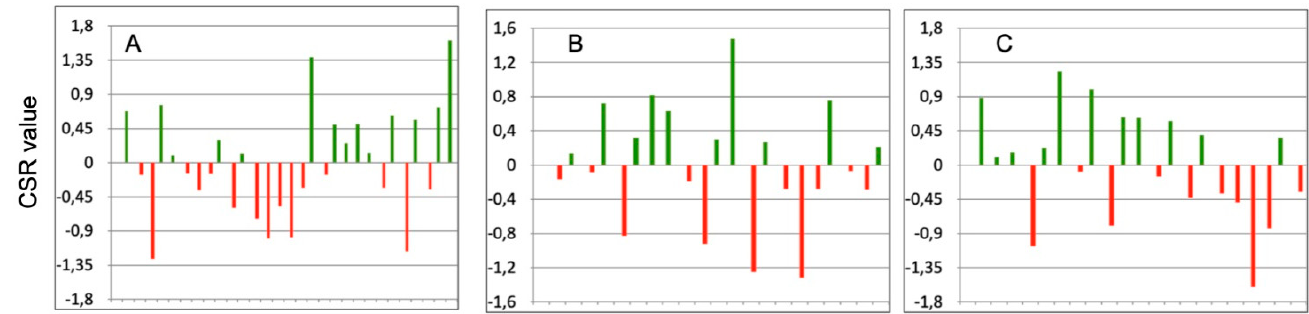
Figure 1. The values of CSR A ( A ), CSR M ( B ), and CSR H ( C ) in athletes relative to the own group. Zero represents the group average CSR value; green bars indicate positive value (it means that the particular athlete is better than average); red bars indicate negative value (it means that the particular athlete is worse than average).